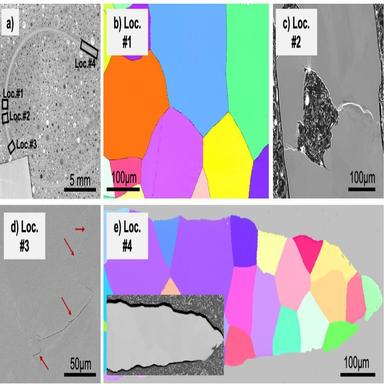
Post-burst microstructure of the cladding tube (Specimen #11). (a) general view of the specimen cross-section; (b) grain structure (EBSD IPF map) at location #1 (opposite to the burst location); (c) complex fracture at Location #2; (d) Internal brittle cracks at Location #3 as indicated by red-arrows; (e) Tube microstructure at Location #4, near the burst point. An inset shows the SEM view for this location indicating no internal cracks.